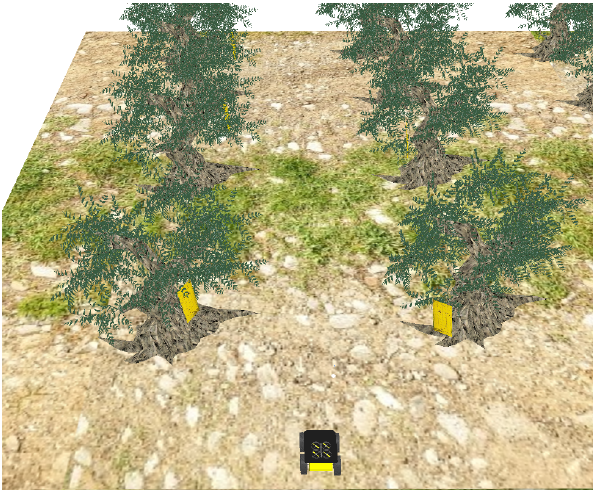
Figure 15. Simulated environment developed to validate the proposed strategy.